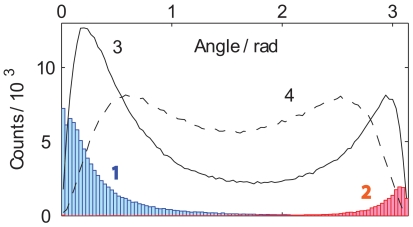
Angular distributions of word pairs on the map.The plots represent histograms of angle distributions for synonyms (1, blue), antonyms (2, red), onyms of onyms not listed as onyms (3, solid black line), and unrelated words (4, dashed line). Here “onym” stands for “synonym or antonym”, and onyms of onyms include synonyms of synonyms, synonyms of antonyms, antonyms of synonyms, and antonyms of antonyms.